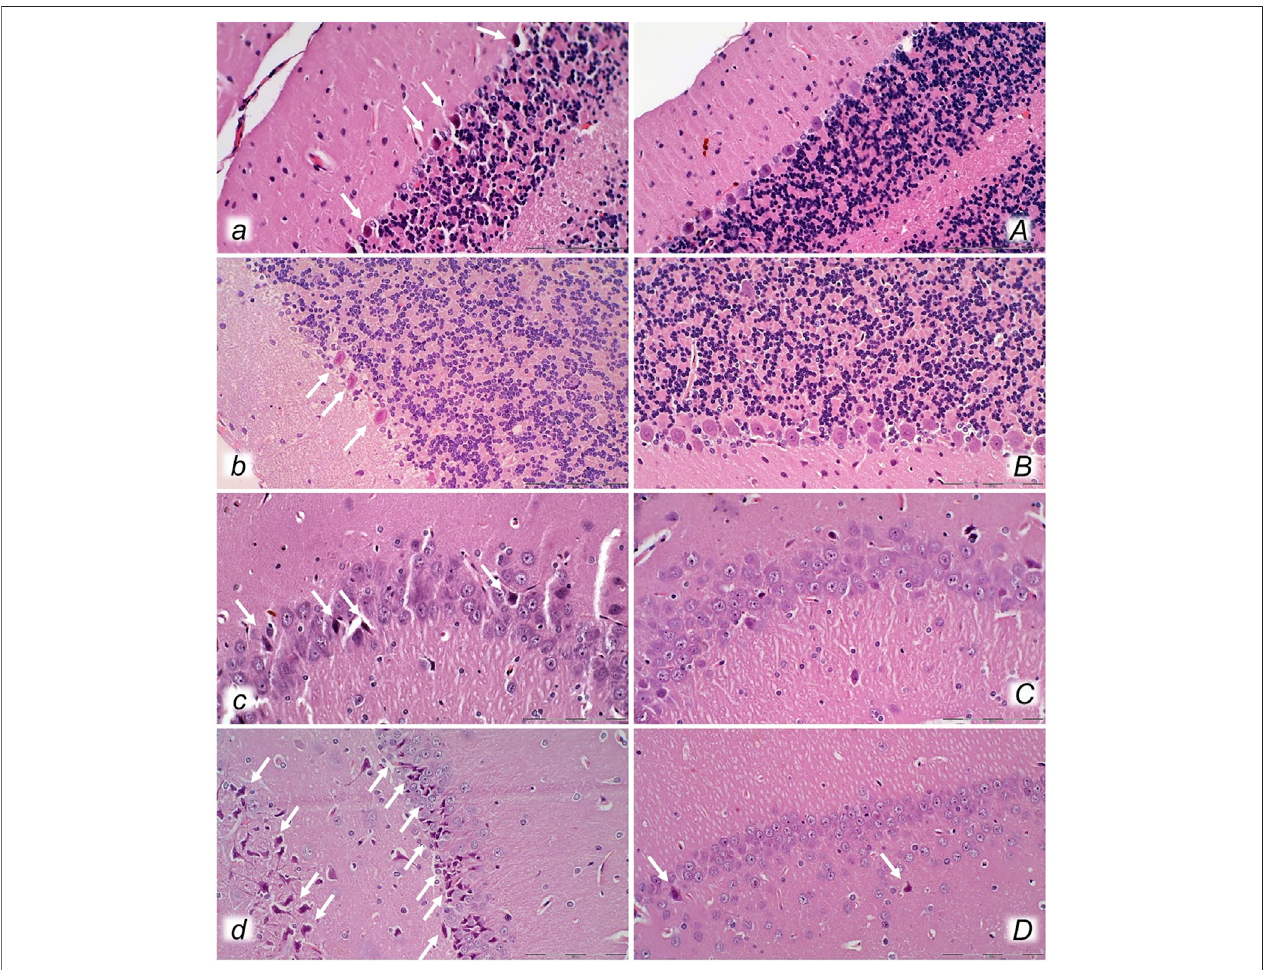
FIGURE 15 | Neuropathological changes of cerebellar cortex ( a, A , b, B ) and hippocampus (c , C, d, D ) in rats with the increased intra-abdominal pressure at 25 mmHg for 60 min ( a, A, c, C ) or at 50 mmHg for 25 min ( b, B, d, D ), treated at 10 min increased intra-abdominal pressure time with saline (control, a, b, c, d ) or BPC 157 ( A, B, C, D ). Control rats exhibited within cerebellar area karyopyknosis and degeneration of Purkinje cells ( a, b ). Marked and progressive karyopyknosis and degeneration of pyramidal cell of the hippocampus was observed in control rats (arrows) at 25 mmHg intraabdominal pressure ( c ) and even more at 50 mmHg intra-abdominalpressure( d ).NochangewasfoundinthecerebellarandhippocampalareainBPC157-treatedratsat25 mmHgintra-abdominalpressure( A,B,C )and only rare hippocampal karyopyknotic cells (arrows) at 50 mmHg intra-abdominal pressure ( D ) (HE; magni fi cation × 400, scale bar 50 μ m).